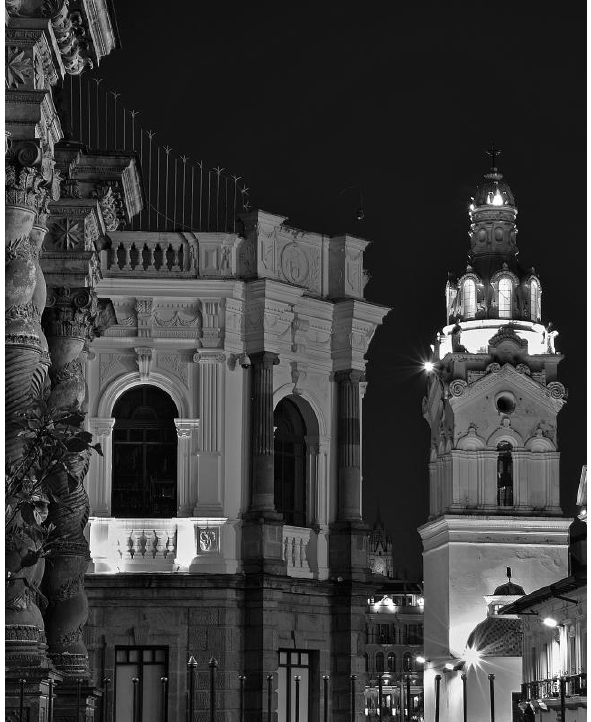
Figure 2. Quito built-up heritage. Photo by Paola